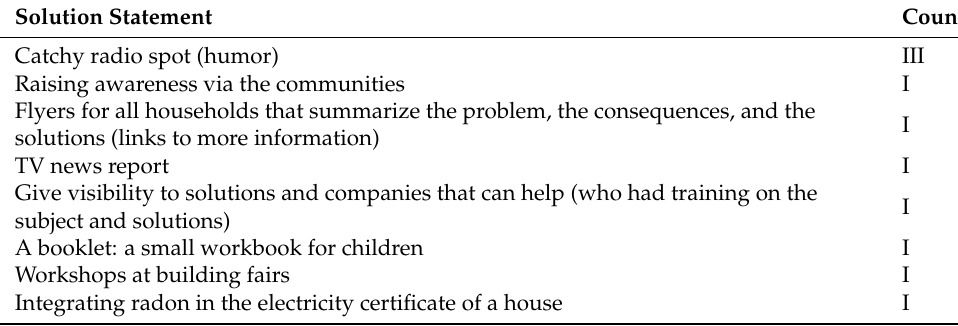
Table 2. Belgium: solution